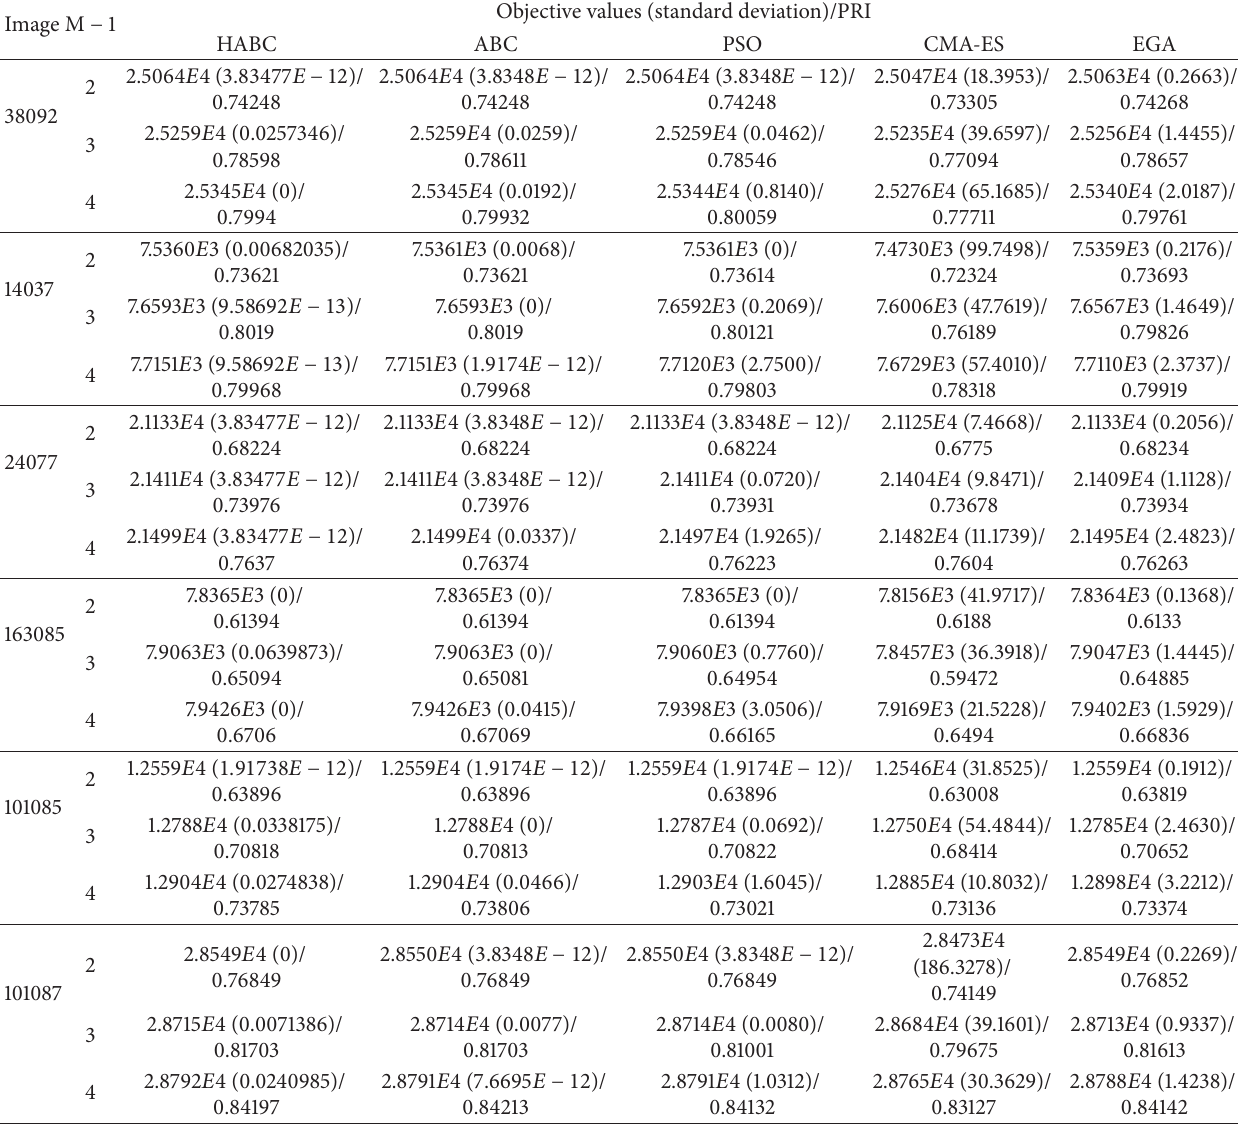
Table 9: Objective value, standard deviation, and PRI by the compared population-based methods on Otsu